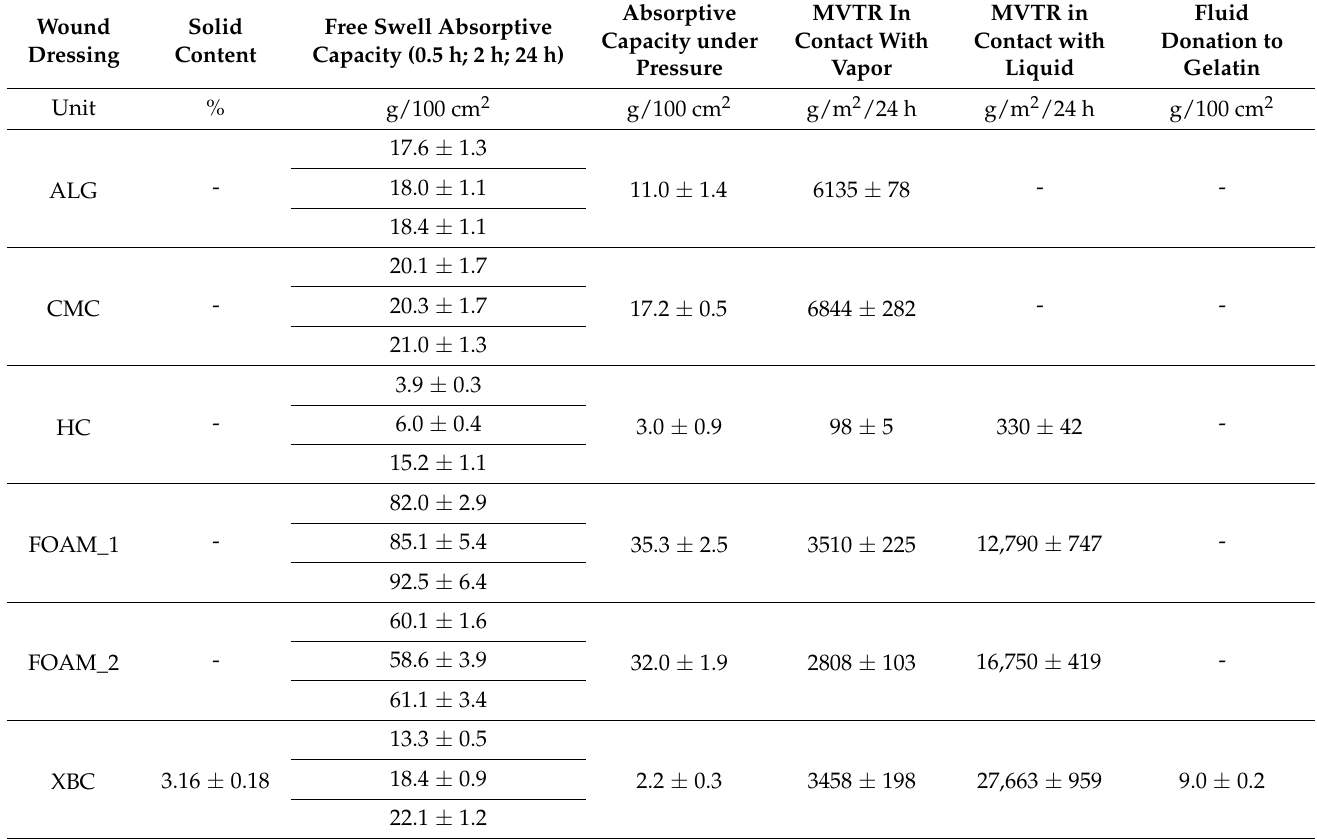
Table 1. Overview of evaluated parameters, tests, and results.